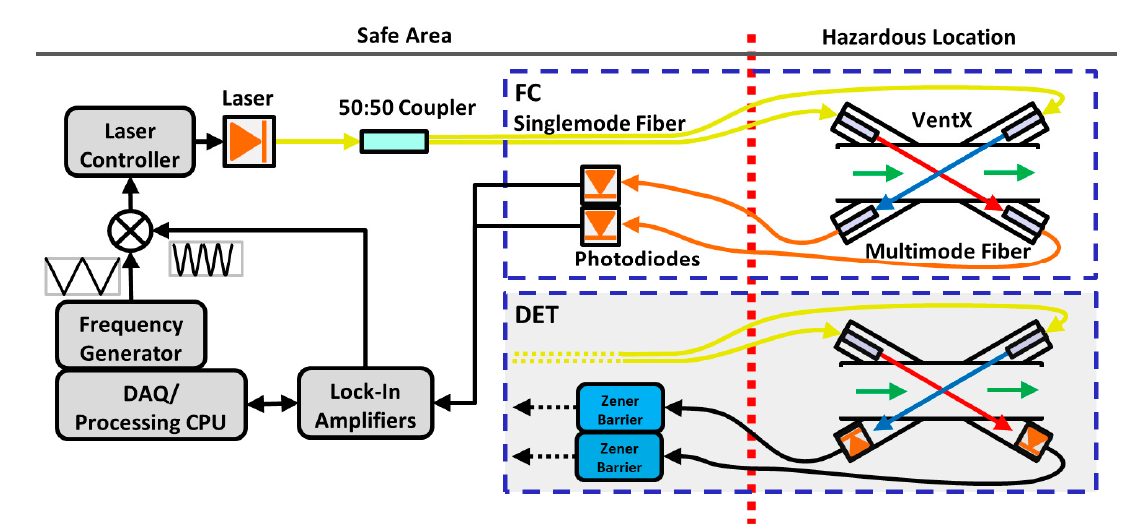
Figure 1. Schematic of the methane flux sensor, illustrating both the fully optical configuration (FC) and detector configuration (DET). A dotted red line separates the Safe Area on the left from the Hazardous Location on the right. Auxiliary intrinsically safe temperature and pressure transducers (not pictured) are included with the flow cell. The two light beams are collimated and arranged in a cross-beam pattern such that one beam is Doppler-shifted to a higher frequency and the other to a lower frequency when gas is flowing through the cell (green arrows). Signals return to the Safe Area as either optical signals in multimode fibers (FC) or electrical signals in conventional cables (DET).